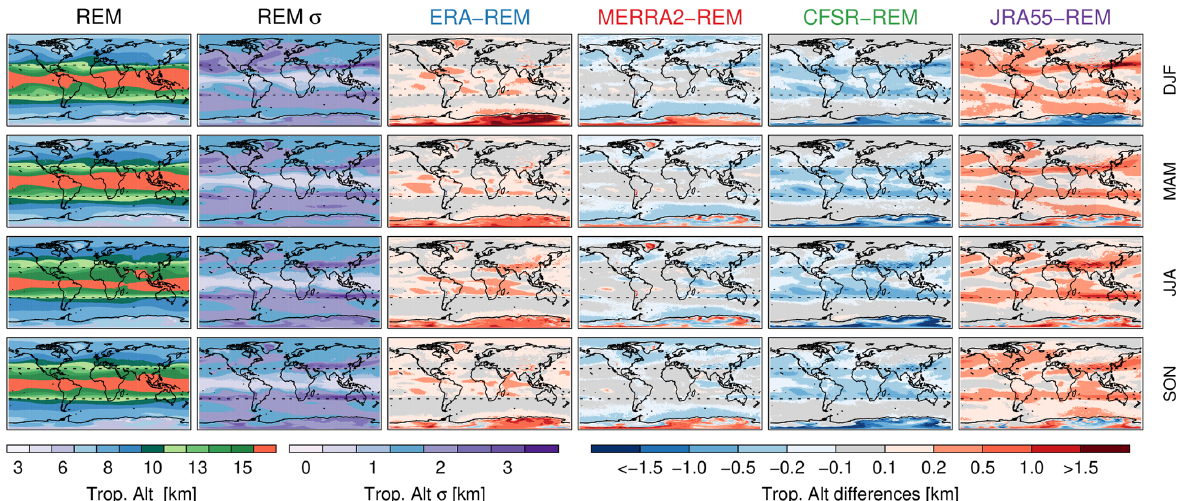
Figure 8. Climatological REM 2PVU tropopause altitudes and standard deviations for different seasons (left two columns). Difference of each reanalysis from the REM (right columns). Dashed lines indicate the 30 ◦ S and 30 ◦ N